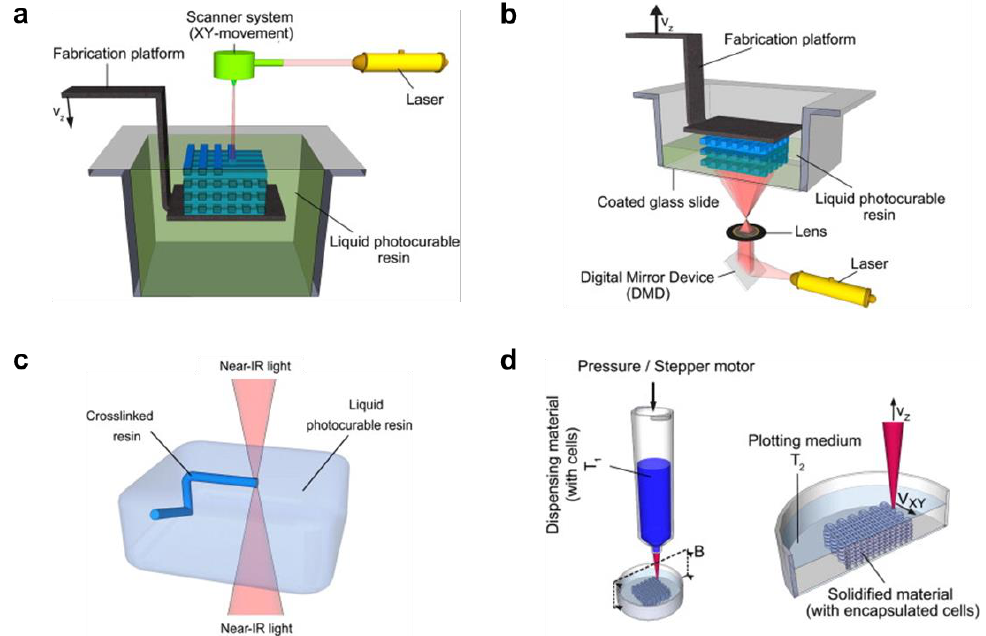
Figure 4. Schematic of ( a ) stereolithography, ( b ) digital light processing, ( c ) two-photon photopolymerization, and ( d ) extrusion 3D bioprinting. Adapted with permission from [118]. Copyright © 2012 Elsevier.